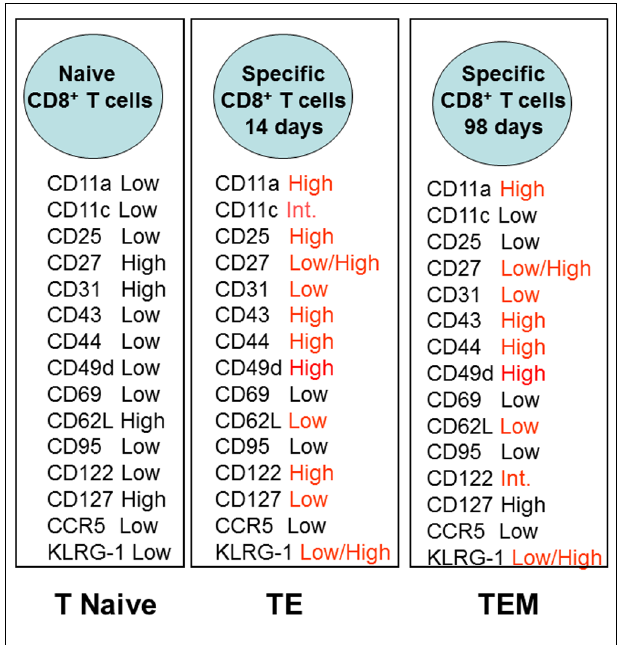
FIGURE 1 | Phenotype of specific CD8 + T cells elicited by heterologous prime-boost vaccination using recombinant plasmid DNA andAdHu5. Prime-boost regimen was performed as detailed described by Rigato etal. (2011). Mice were primed i.m. with plasmid DNA (100 μ g) and boosted 21 days later with AdHu5 (2 × 10 8 ) both expressing the gene encoding the amastigote surface protein-2 of T. cruzi . Expression of distinct adhesion/activation receptors on the surface of splenic CD8 + specificT cells is shown at day 14 or day 98 after the boost